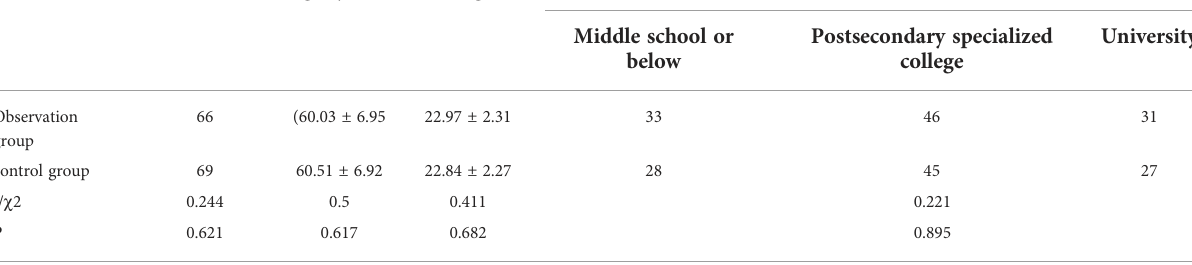
TABLE 1 The basic data of both